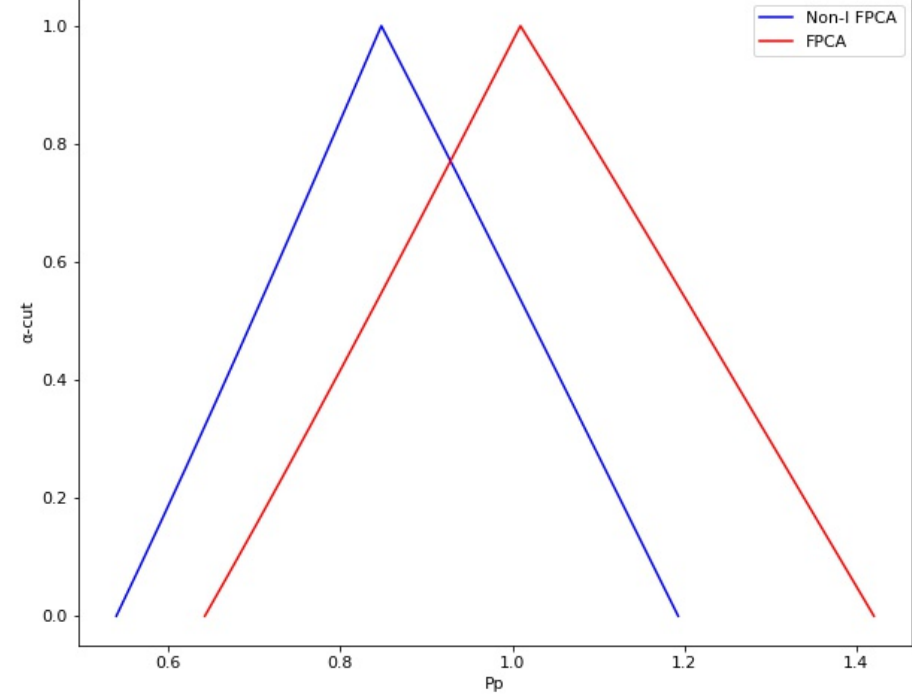
𝑃(cid:3552)(cid:3560) (cid:3043)(cid:3030) .